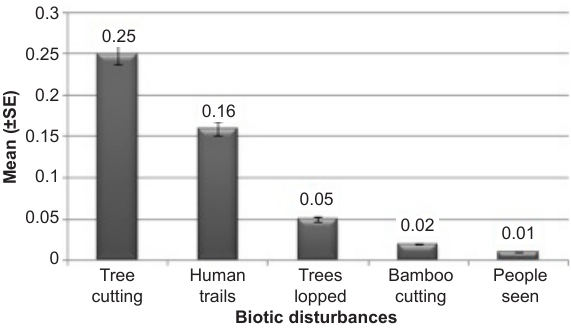
Figure 2. Estimated Mean (±SE) of biotic disturbances recorded from Melghat Tiger Reserve, Maharashtra during (October 2010 to March